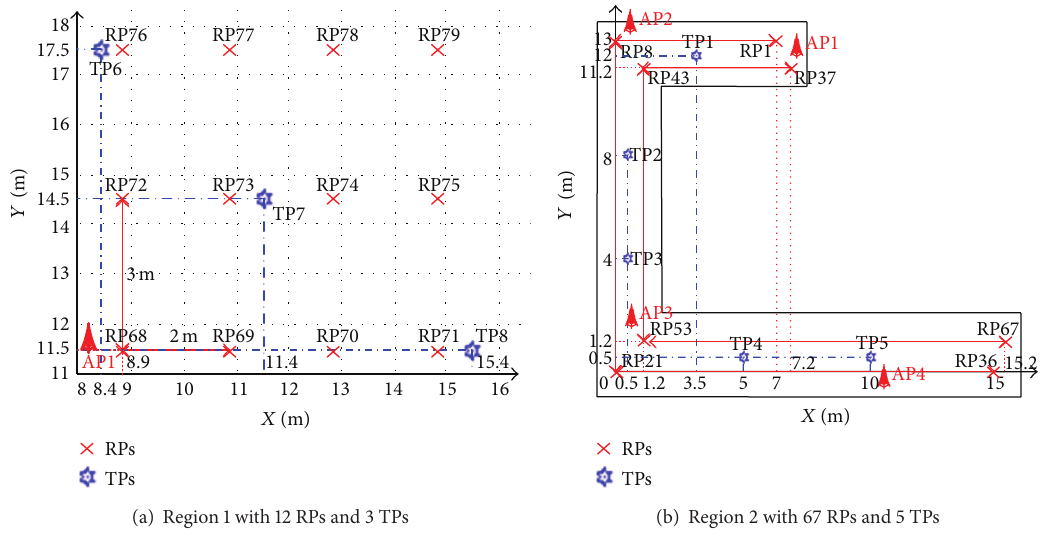
Figure 10: Locations of RPs and TPs in target